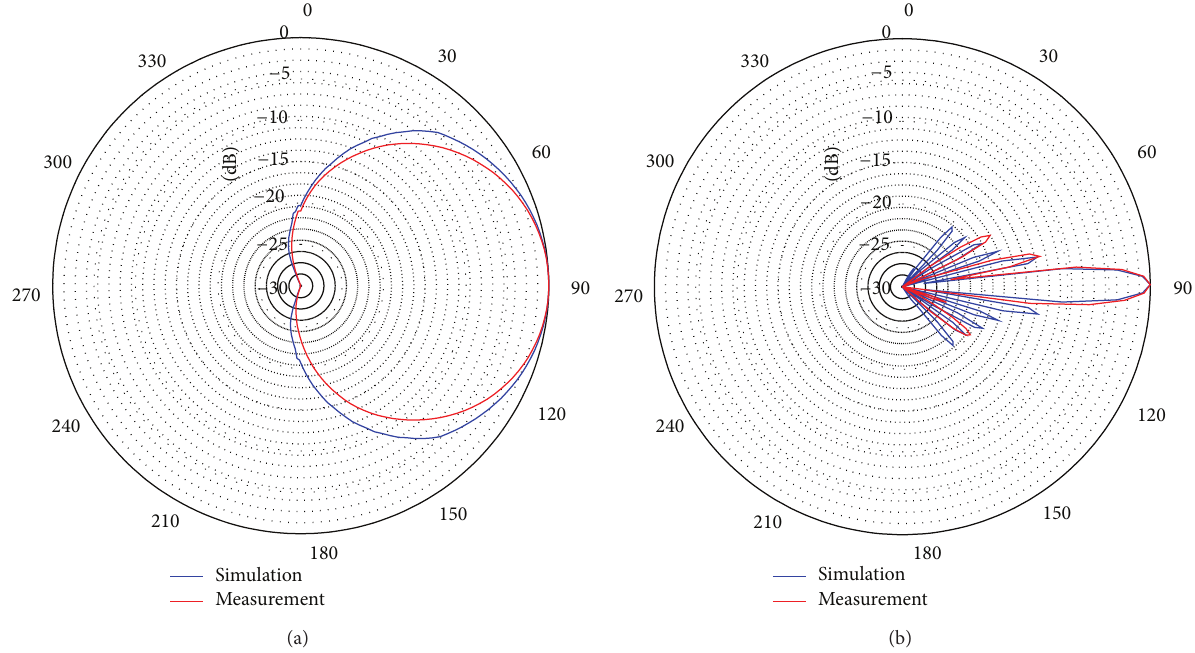
Figure 6: Comparison of radiation patterns at 1920 MHz on the horizontal and vertical planes obtained by FDTD method and measurement. (a) Horizontal plane (𝜙) . (b) Vertical plane (𝜃) .